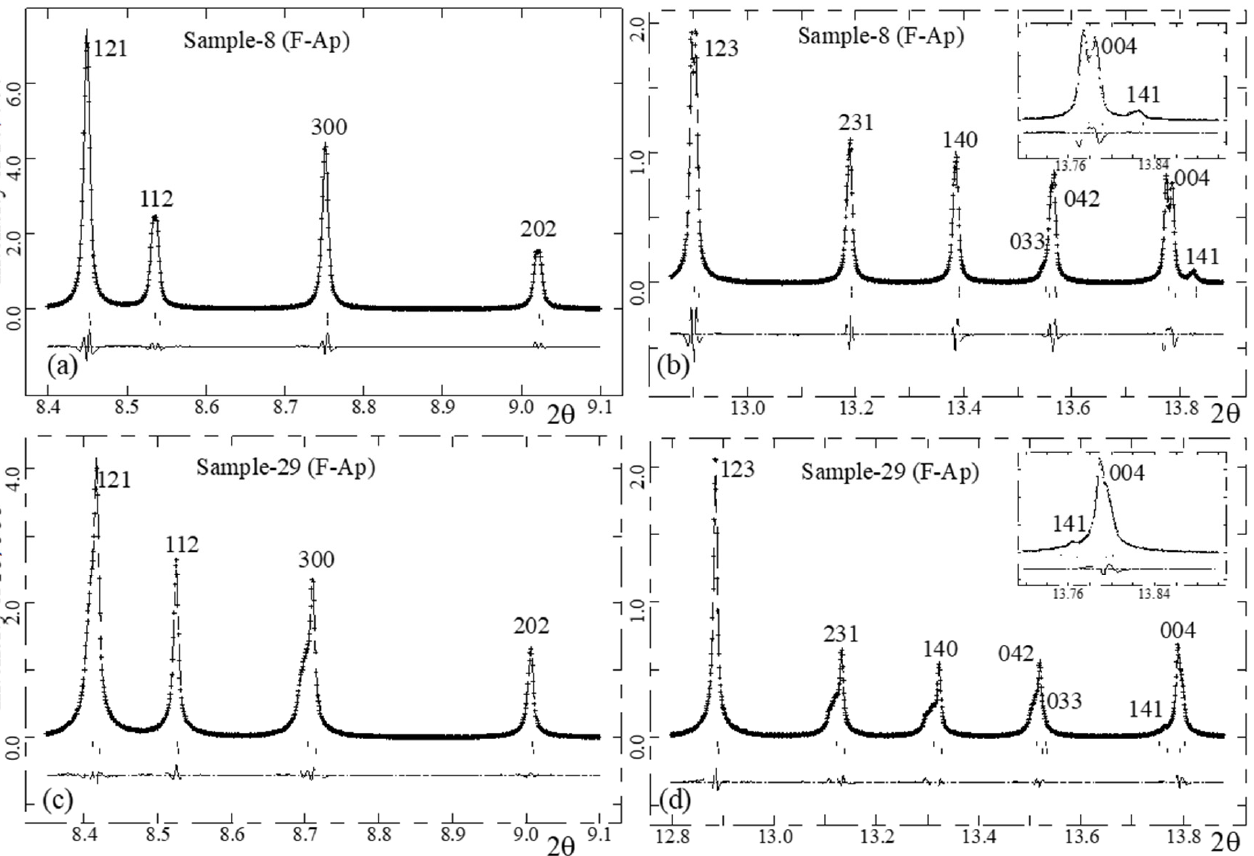
Figure7 Figure 7. Comparison of HRPXRD traces at 20 ◦ C: ( a , b ) is a two-phase intergrowth of two different F-Ap phases (48 and 52 wt.%) in sample-8; ( c , d ) is a two-phase intergrowth of F-Ap in sample-29 (55 and 45 wt.%). The two-phase samples are based on the structure refinement and split reflections, especially the 004 reflection in ( b ). In sample-29, one phase occurs as a sharp peak, and the other as a broad hump (e.g., 140 reflection in ( d